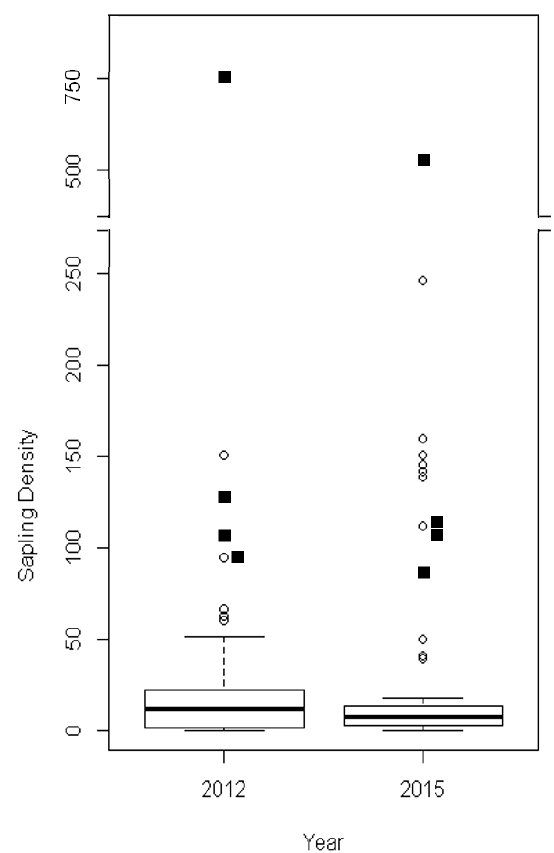
Figure 2. Sapling densities per 200 m 2 are represented for each sampling location in a boxplot in 2012 and 2015. The box plot shows the median (thick black line) and 75th and 25th percentile values (box outline) for sapling densities within sampling locations. Outliers are defined as points that are 1.5 times higher than the upper quartile and are represented as circles. Sapling densities within exclosures are shown as black squares and were not included in the boxplot analysis. Break in the y -axis indicates a scale change.